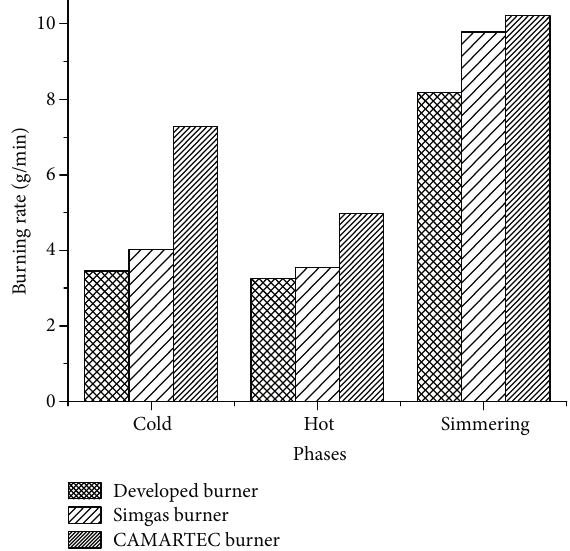
Figure 12: Burning rates of the developed burner and the Simgas and CAMARTEC burners.